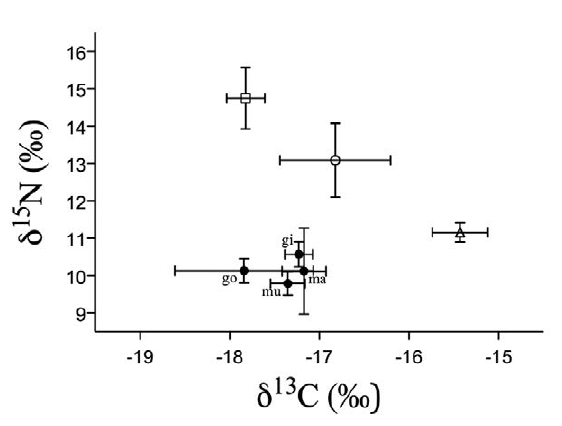
Fig. 2. – Mean (±sd) δ 13 C and δ 15 N values of the carapid fish Onuxo­ don fowleri (white square), the palaemonid shrimp Conchodytes meleagrinae (white circle), zoobenthos (white triangle), and tissues of the black-lip pearl oyster Pinctada margaritifera (black circles) from Makemo Atoll (Tuamotu Archipelago, French Polynesia); gi, gills; go, gonads; ma, mantle; mu,